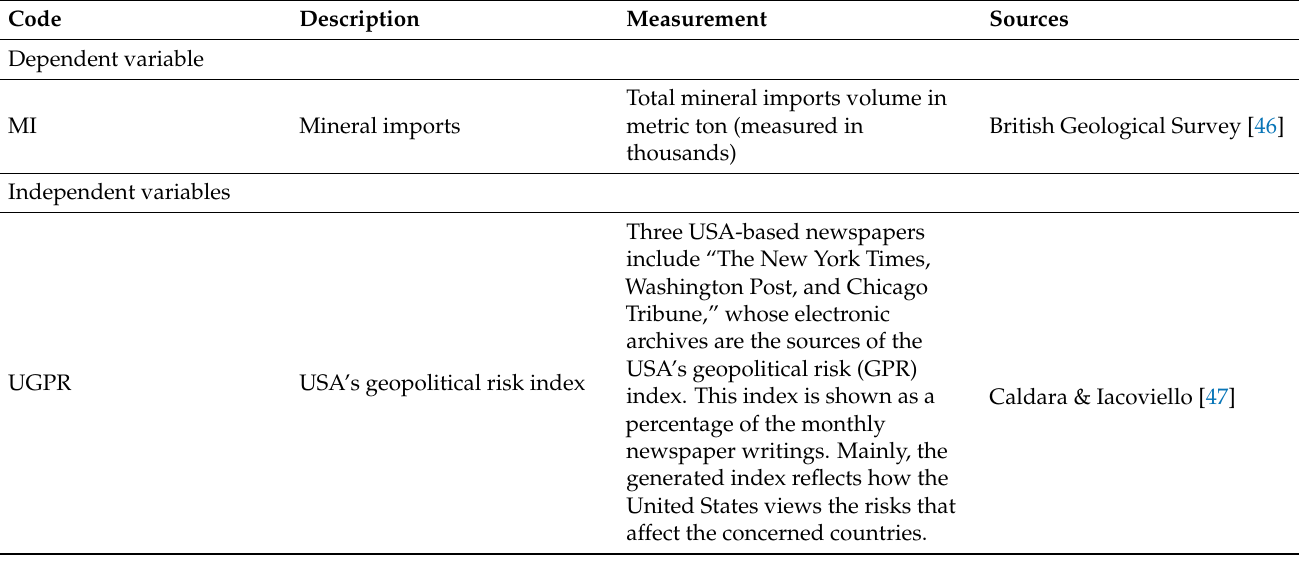
Table 1. Data descriptions and